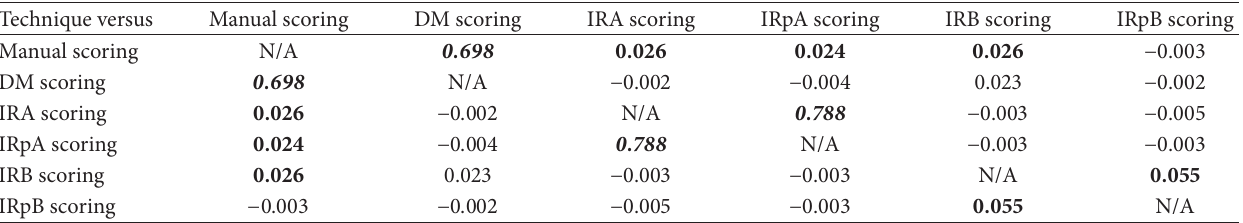
Figure 4: Photomicrograph of a solid ameloblastoma specimen at 400x magnification using the advanced ImmunoRatio method. The online advanced ImmunoRatio method (IRA scoring) was performed at http://153.1.200.58:8080/immunoratio/ using the previously validated blank field image and the appropriate changes for cell counting. These changes are shown in Figure 5(a). Table 3: The cell counting methods used to determine the labeling index. The kappa coefficient was obtained by comparing each method. The manual (manual scoring and DM scoring) and advanced ImmunoRatio (IRA scoring and IRpA scoring) methods showed substantial kappa coefficients. Italic text indicate substantial kappa coefficient and bold text indicates a significance level of 𝑝 < 0.05